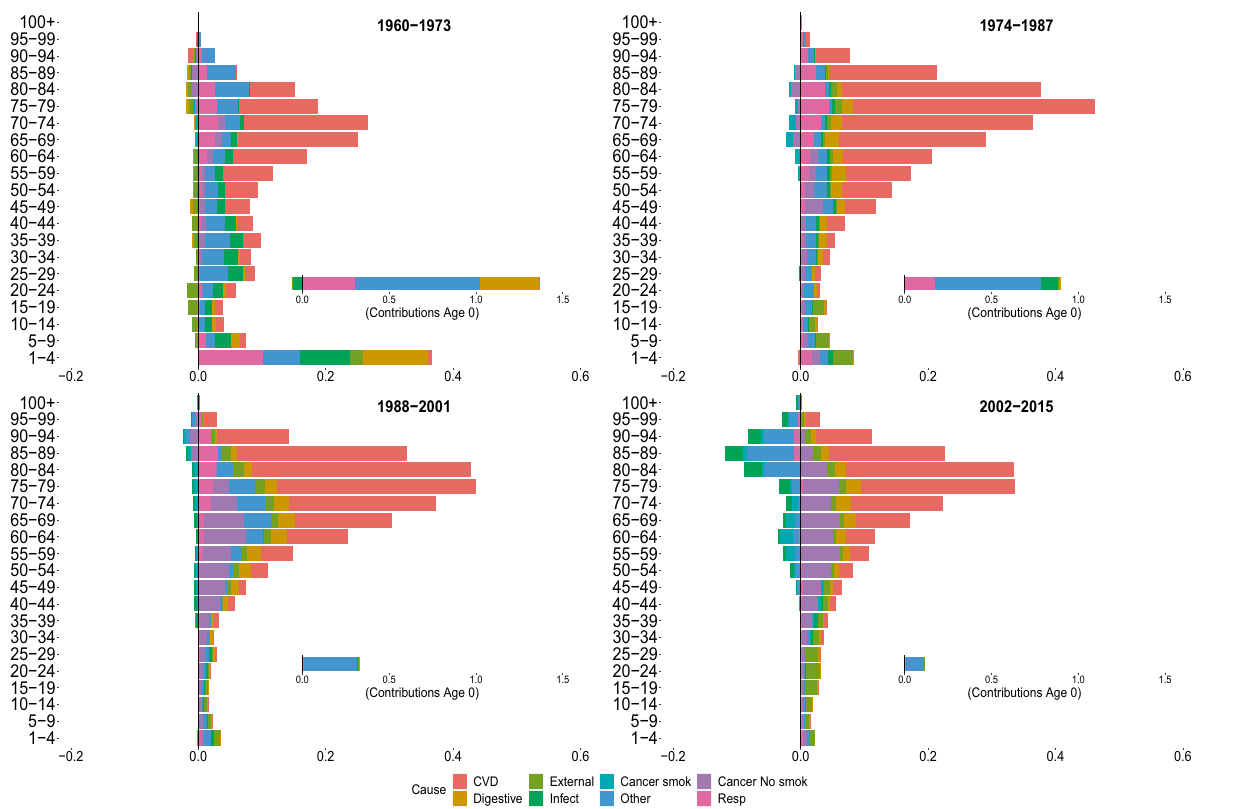
Figure 2. Age and cause contributions to changes in life expectancy for Italian